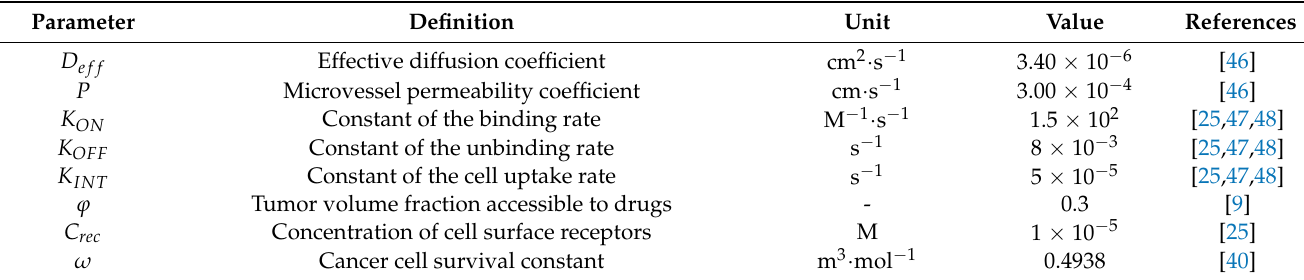
Table 2. Solute transport parameters used in the